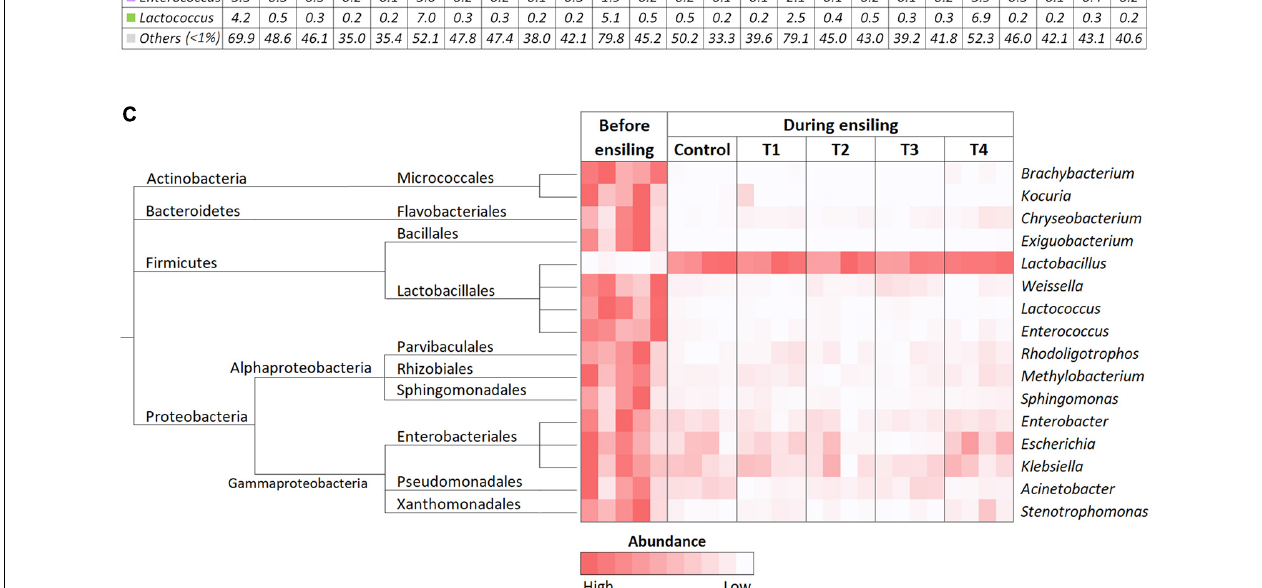
Frontiers in Microbiology |